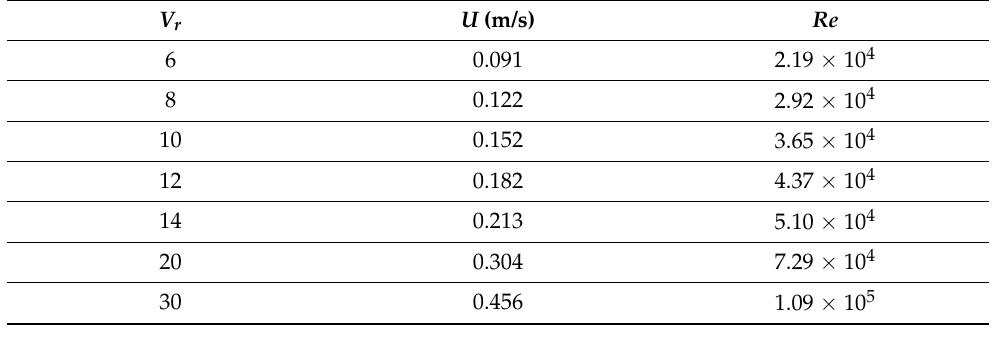
Table 2. Flow conditions for VIM of FOWT platform.